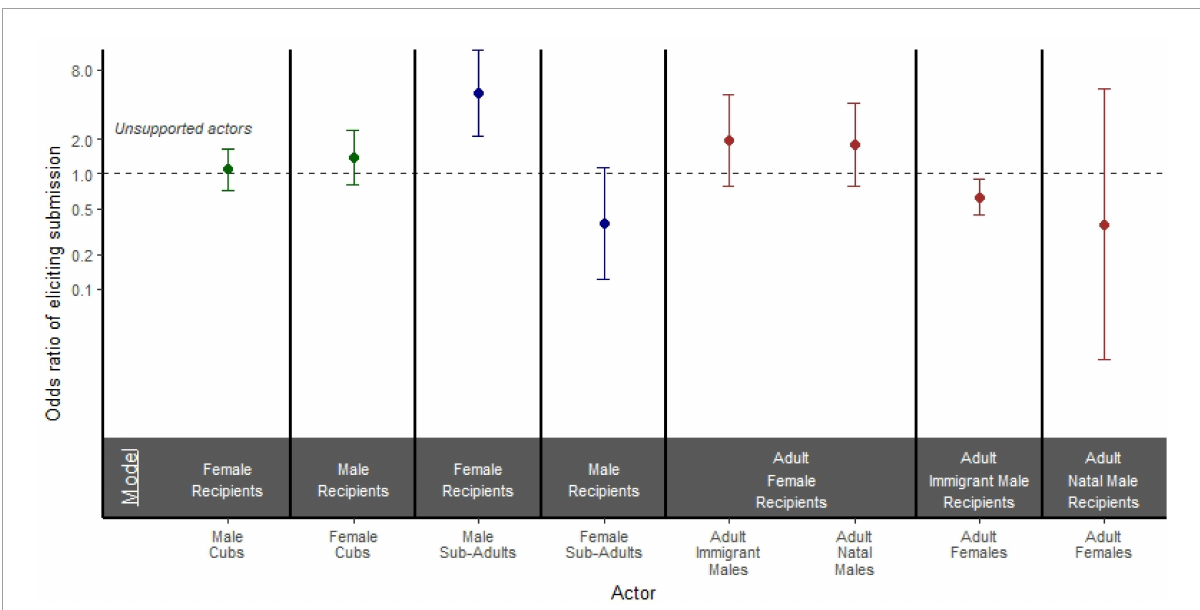
FIGURE5 Odds ratio of a supported versus unsupported actor eliciting a submissive response from a recipient of the opposite sex in models stratified by both actor age and actor sex. Models are separated by bold black lines, and age is depicted by color where cubs are green, subadults are blue, and adults are brown. Points represent the odds ratio and error bars represent 95% confidence intervals around the odds ratio. Each point is compared to an unsupported actor reference group of the same age and sex class represented by the black dashed